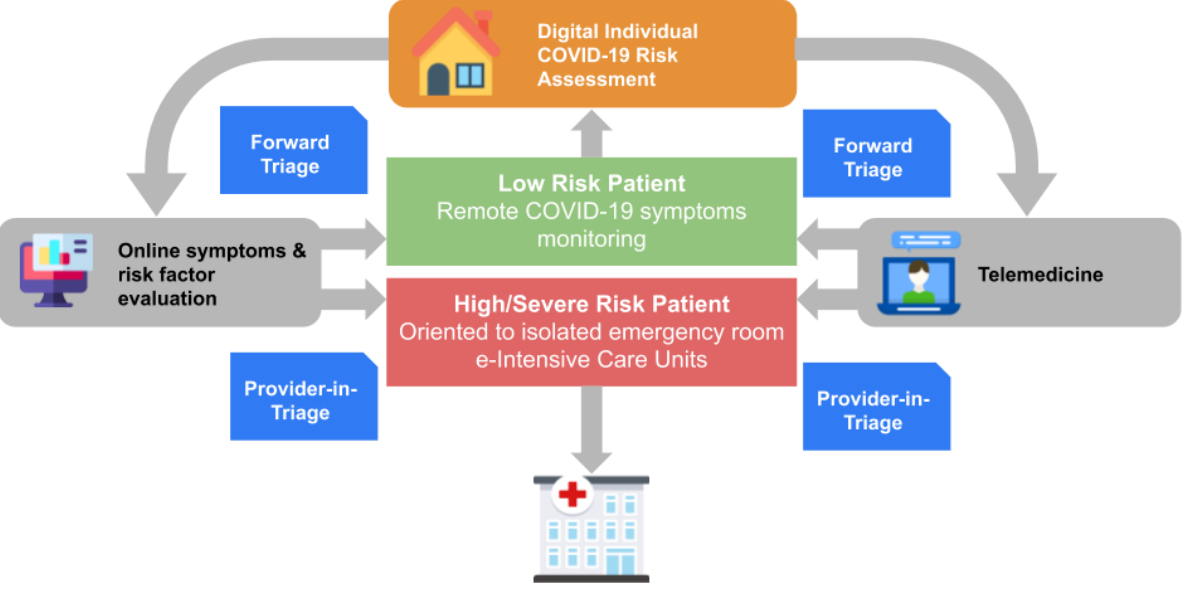
Web-based symptom trackers such as